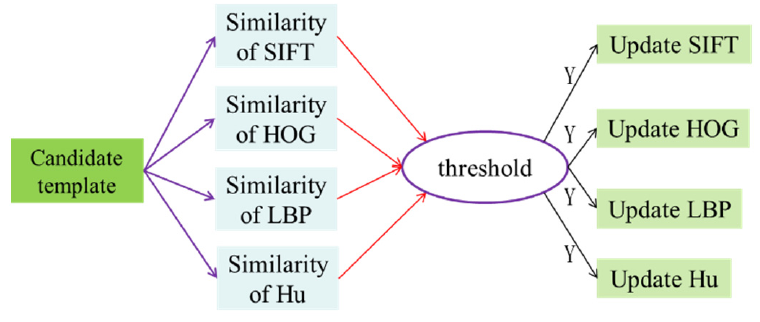
Figure 10. Template update schematic. Determine target: Carry out probability conversion for each classification plane (each column) in matrix C and take the classification plane with the largest probability as as follows: